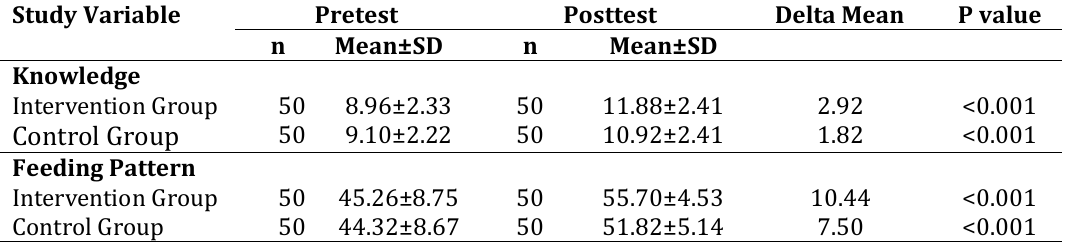
Comparison of Knowledge Level and Feeding Pattern in Children Aged 0-24 Months Before and After the Intervention in the Intervention Group and the Control Group Study